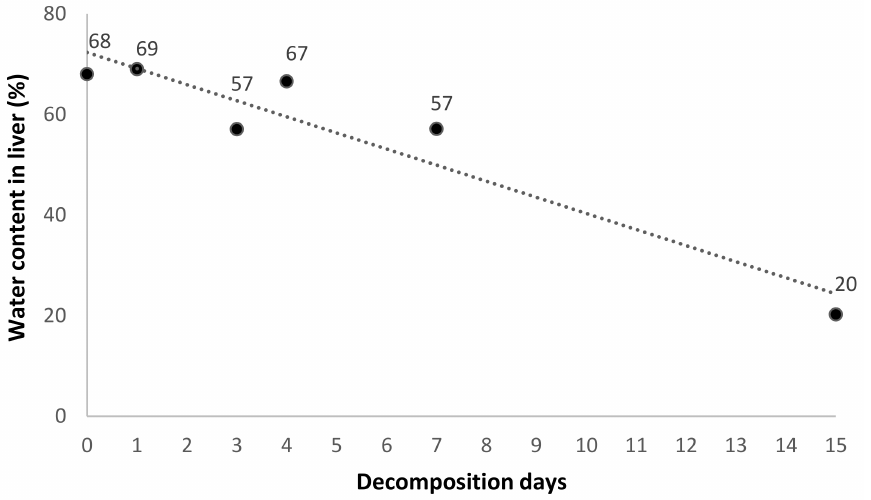
Figure 2. Water content in tissue (%) over time (decompositions days) in decaying carcasses of common kestrel ( r = − 0.95, p < 0.01). Numbers above circles indicate the mean water content (%) for the control and dosed individual at each time point.